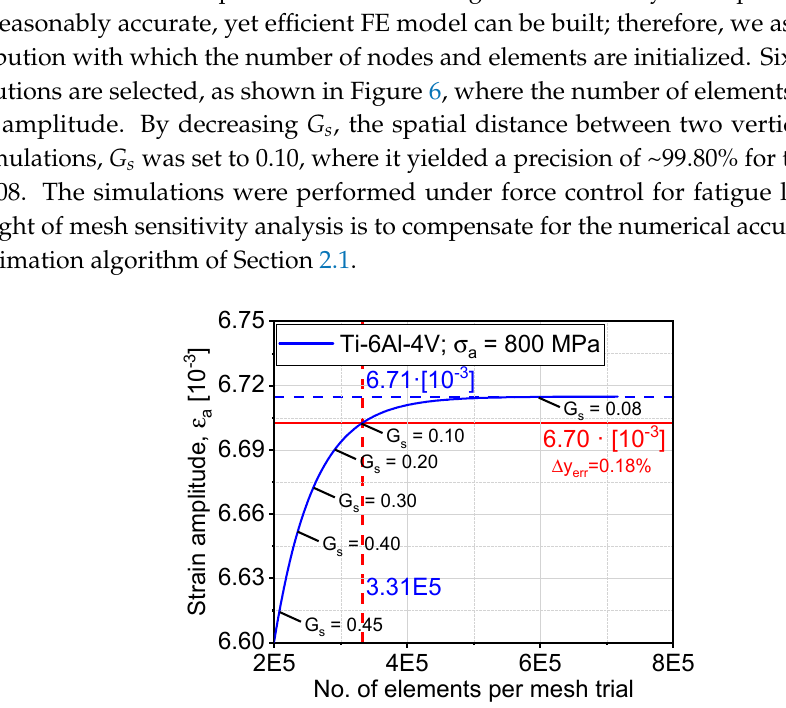
Figure 6. Mesh sensitivity analysis for the determination of an optimum number of elements and element size.